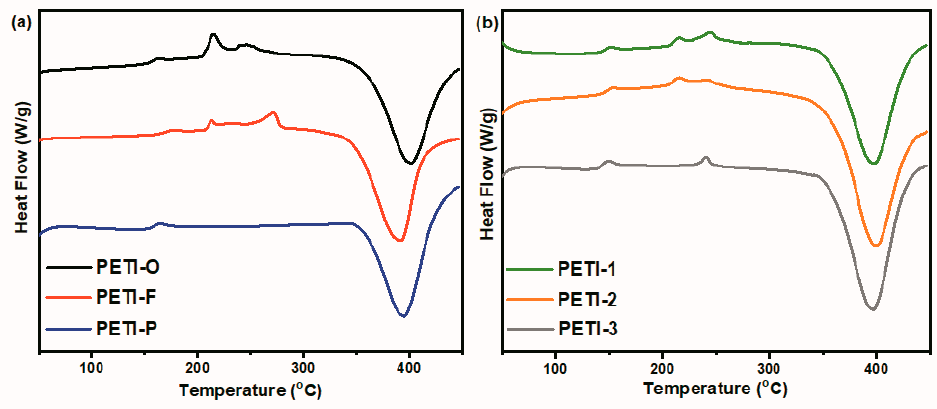
Figure 3. DSC curves of ( a ) PETI-O, PETI-F, PETI-P and ( b ) PETI-1, PETI-2, PETI-3. PETI-1, PETI-2 and PETI-3 show T g of 144–148 °C. It was also found that the intro- Table 2. Complex viscosity data of duction of m-PDA decreases the crystalline of oligoimides. The melting enthalpy of oli- goimides decreased from 38.7 J/g of PETI-O with no m-PDA moieties in its main chains to 6.30 J/g of PETI-3, which was synthesized by 3,4 ′ -ODA and m-PDA at a mole ratio of 50:50.